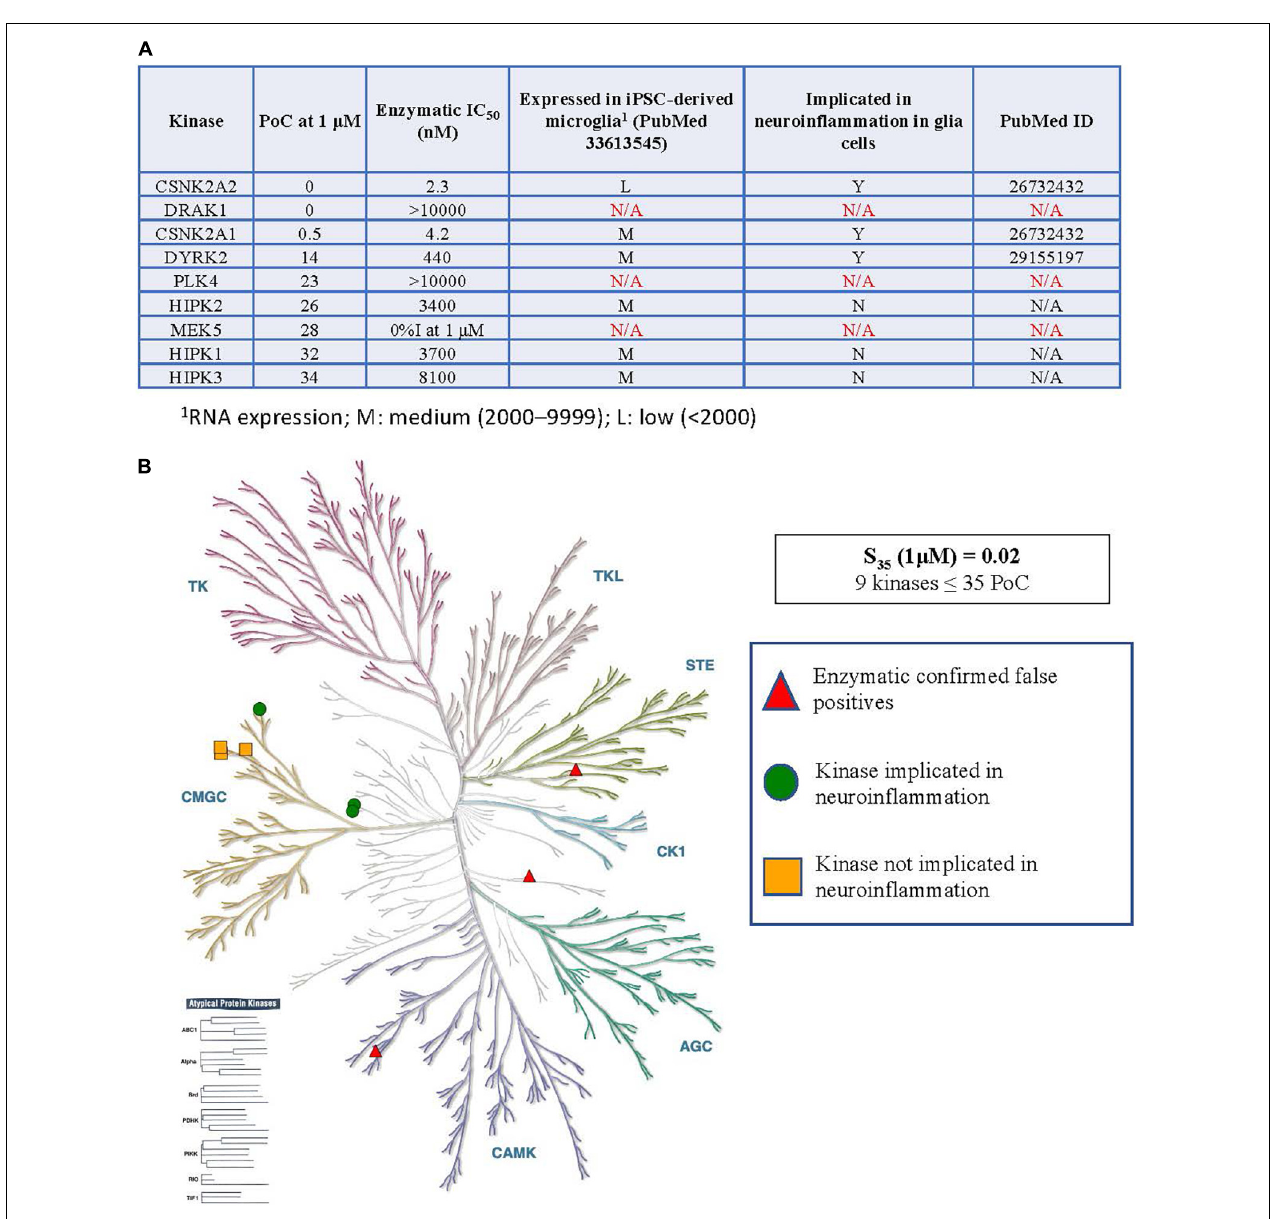
FIGURE 2 | Kinases inhibited by SGC-CK2-1 implicated in neuroinflammation. (A) Table of S 35 kinases, corresponding enzymatic follow-up, expression of inhibited kinases (minus confirmed false positives) in microglia, and reported connections to neuroinflammation in glial cells. (B) Visual representation of the distribution of S 35 kinases around the kinome tree. 1 RNA expression; M, medium (2,000–9,999); L, low ( <